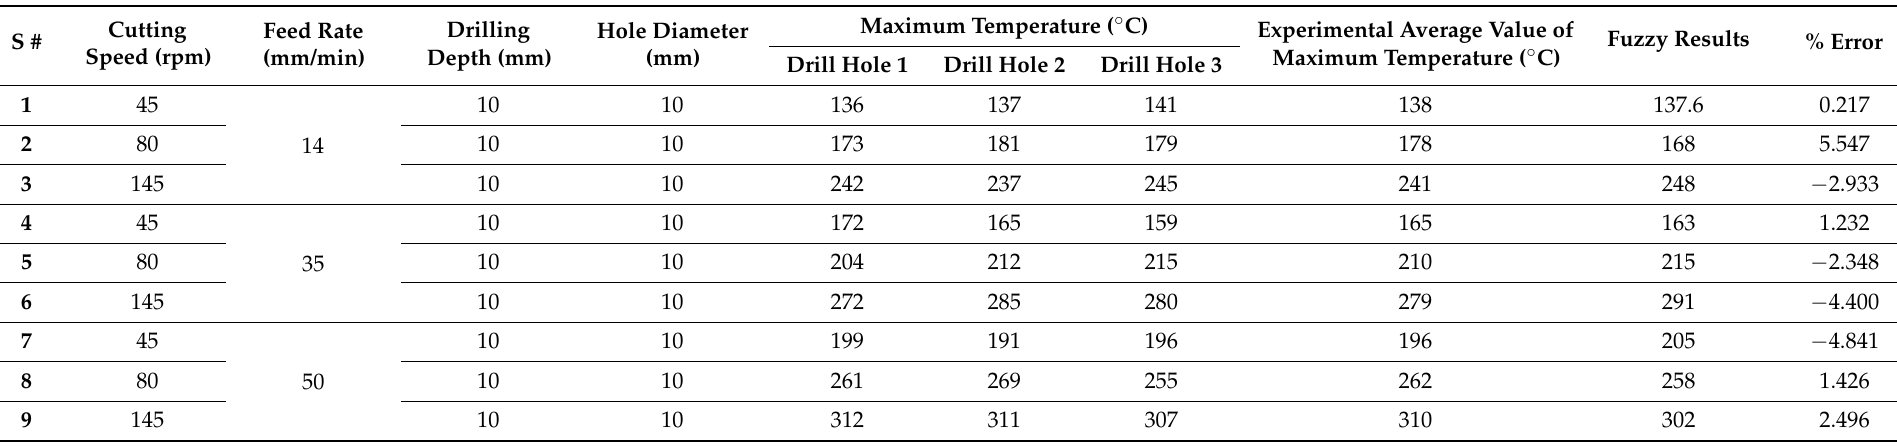
Table 8. Experimental and fuzzy results with percentage error for maximum drilling induced temperature at the tool–material contact